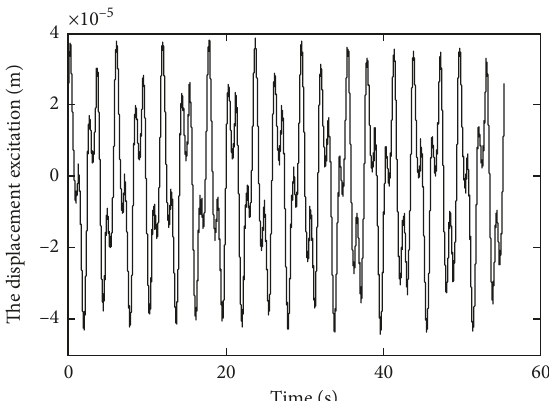
Figure 13: Displacement excitation of gear pair in low-speed situation (50.8 rpm) (the value of displacement excitation in the high-speed situation (2104rpm) is the same as that in this